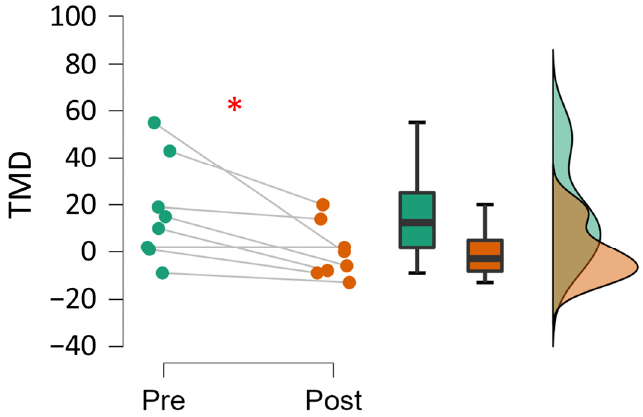
Figure 5. Changes in TMD scores by virtual forest game (pre- and post-value). * p < 0.05. Table 4. Statistical results for changes in TMD scores pre and post virtual forest game.